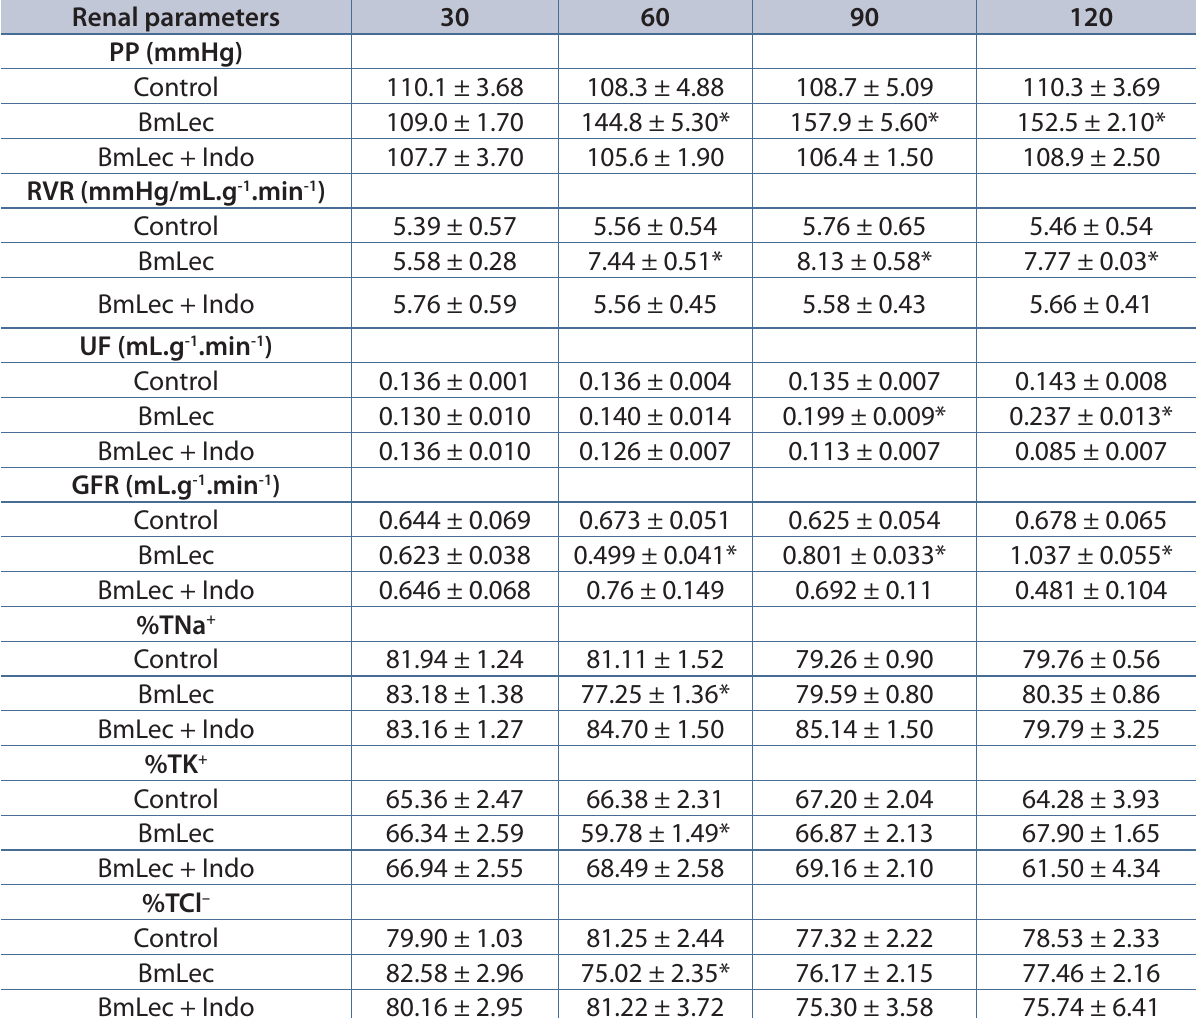
Table 2. Renal effects of a C-type lectin isolated from Bothrops moojeni